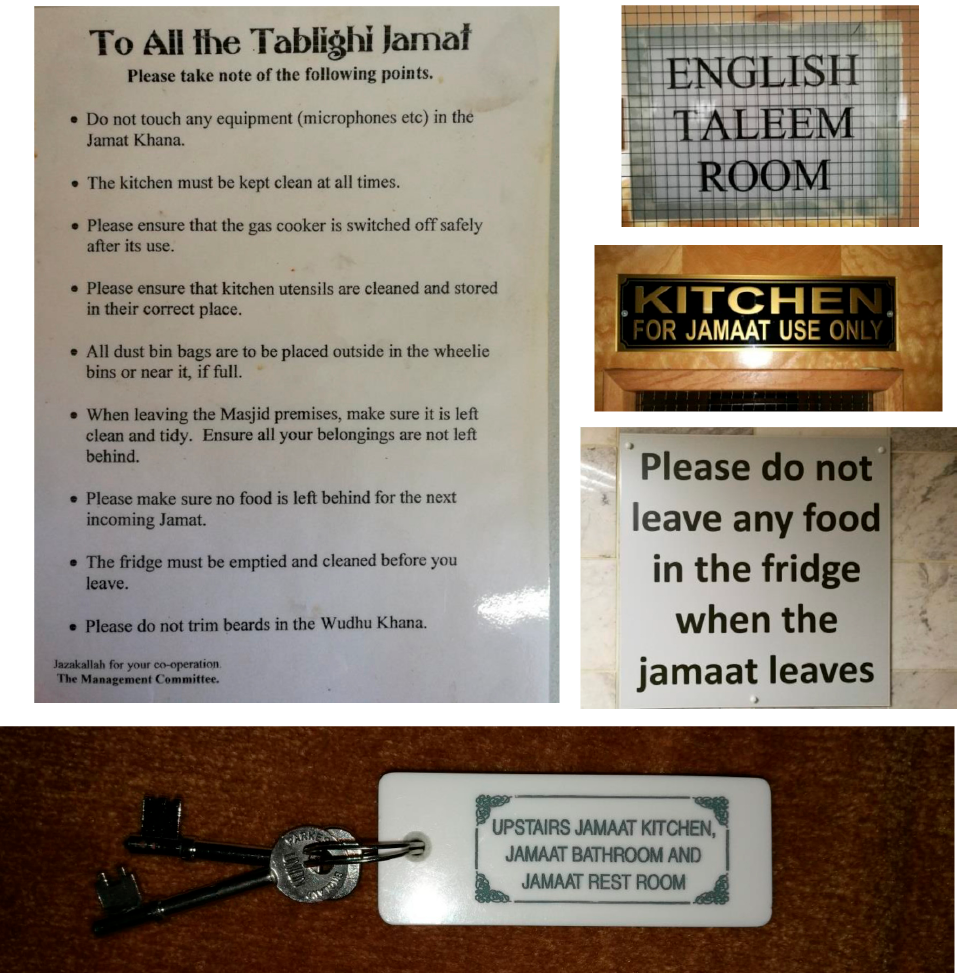
Figure 6. A collection of signs indicating TJ’s entrenchment on the landscape of many British mosques. Source: author’s photos.